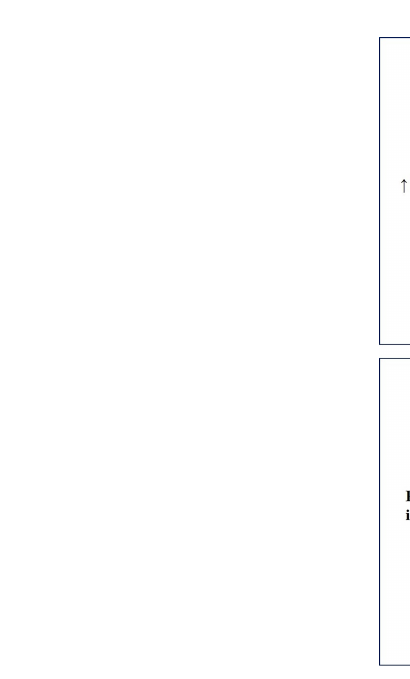
FIGURE 4 | Summary of the two hypothesized mechanisms to explain the susceptibility of obese patients to bone fractures. The negative effects of adiposity on bone fragility are reported in the upper box: obesity is associated with alterations in adipokines and cytokines levels, deregulation of peptides and hormones related to bone metabolism, and dyslipidaemia (112, 146). All these factors contribute to alter bone resorption and formation, by acting directly on osteoclast and osteoblast or indirectly through different molecular pathways. The factors that in fl uence the risk of falling in obesity are reported in the lower box: the mechanistic links between falls and obesity include chronic health conditions, medication use and sedentary behaviour, which lead to a reduction in muscle strength and agility (147). Moreover, biomechanical alterations including poor muscle quality, impaired postural control and osteoarthritis, may reduce postural stability and muscle performances, thus inducing walking de fi cit and functional disability (148 –